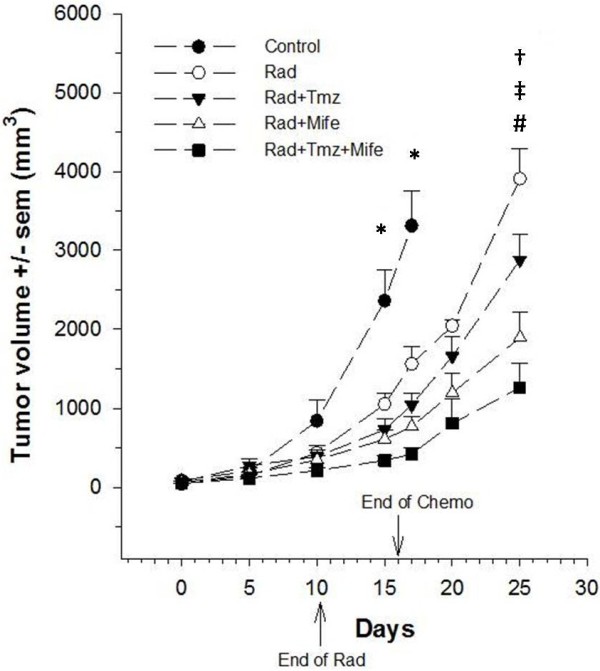
Antitumor activity on glioblastoma xenografts for control and experimental groups. Ionizing radiation alone (Rad) or combined with Temozolamide (Rad + Tmz), Mifepristone (Rad + Mife) or both (Rad + Tmz + Mife). Each point represents the average ± SEM of four to five animals. (*) indicates a significant difference (p < 0.05) between the control and experimental groups; (†) and (‡) represent a significant difference between Rad + Tmz + Mife vs. Rad and Rad + Tmz + Mife vs. Rad + Tmz, respectively. (#) indicates a significant difference between Rad vs. Rad + Mife.